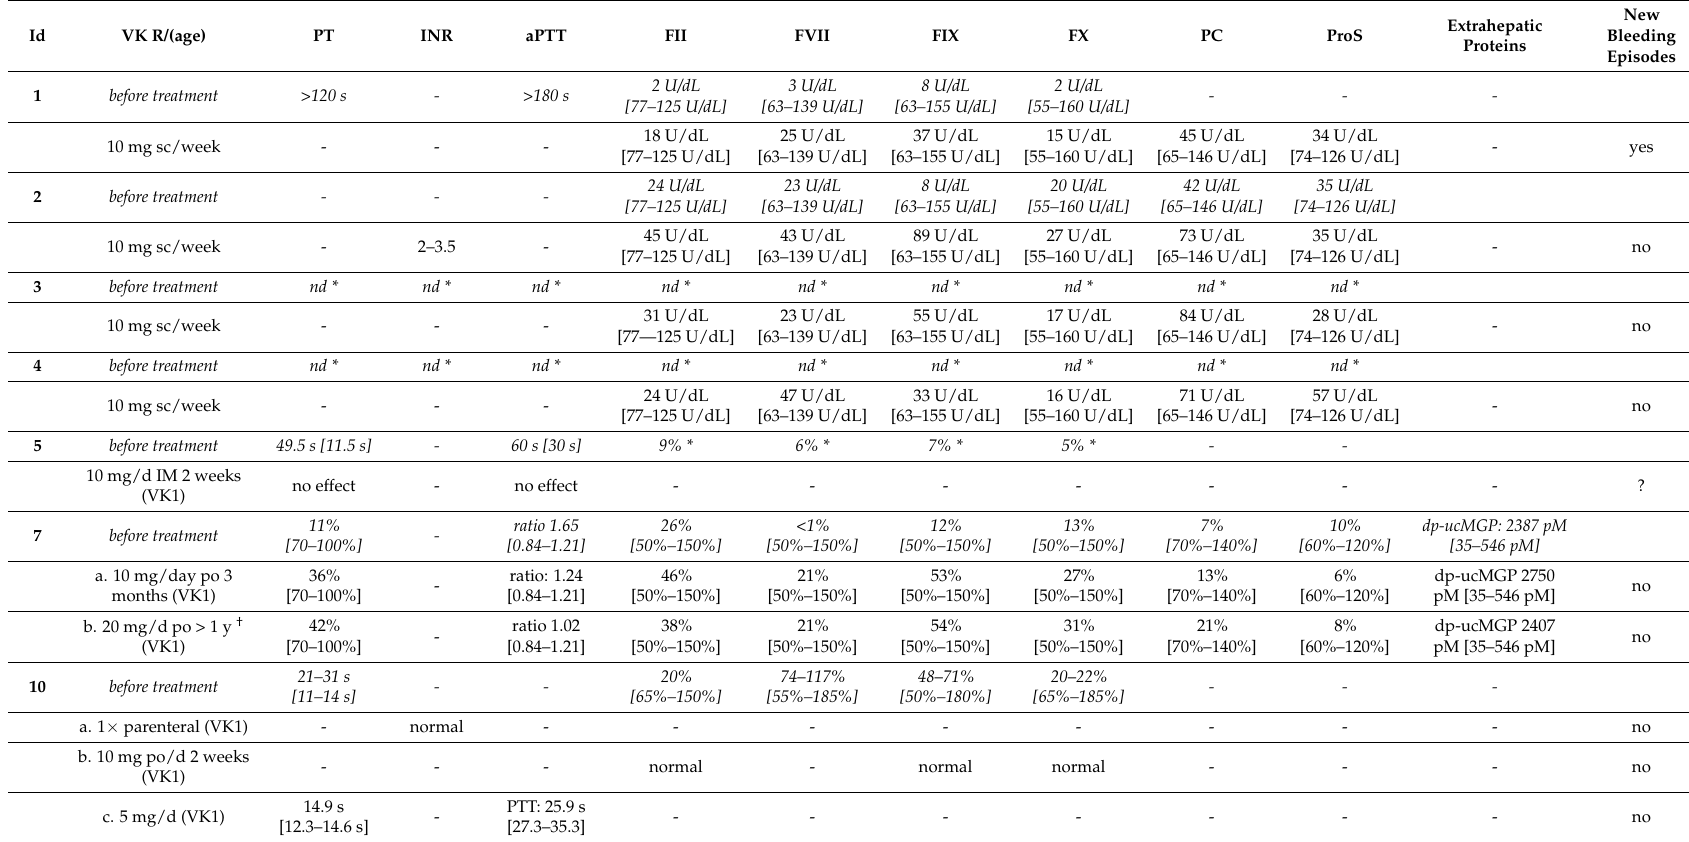
Table 9. Vitamin K treatment in VKCFD1 patients with GGCX mutations. This table gives an overview of all patients who received vitamin K treatment for their coagulation factor deficiency and the response to treatment. For each patient, an overview of the PT, aPTT, coagulation factor function (percent of normal activity or in U/dL or U/mL) prior to therapy is given (in italics) and extrahepatic (non-hemostatic) before treatment parameters are shown (in italics), if determined. Further, the clinical response to treatment is mentioned. For P21, P27, P28, and P29, the response to treatment for the ucOC/cOC ratio is given, but the specific vitamin K dose at the time of blood sampling is not mentioned in the original article. Reference values are stated between brackets if they were mentioned in the original article.